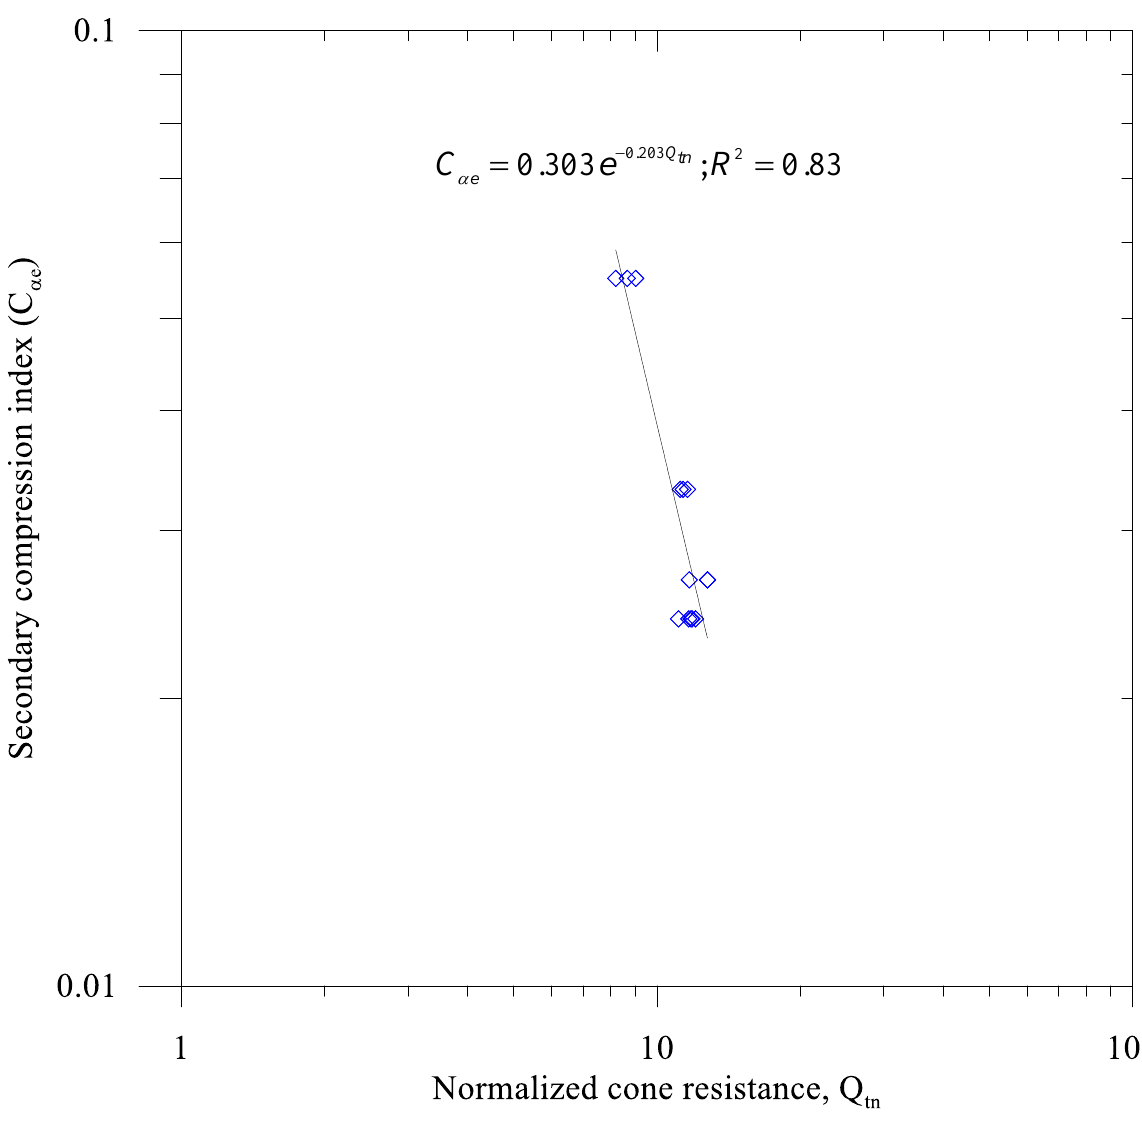
Figure 17. Measured secondary compression index and normalized cone resistance.